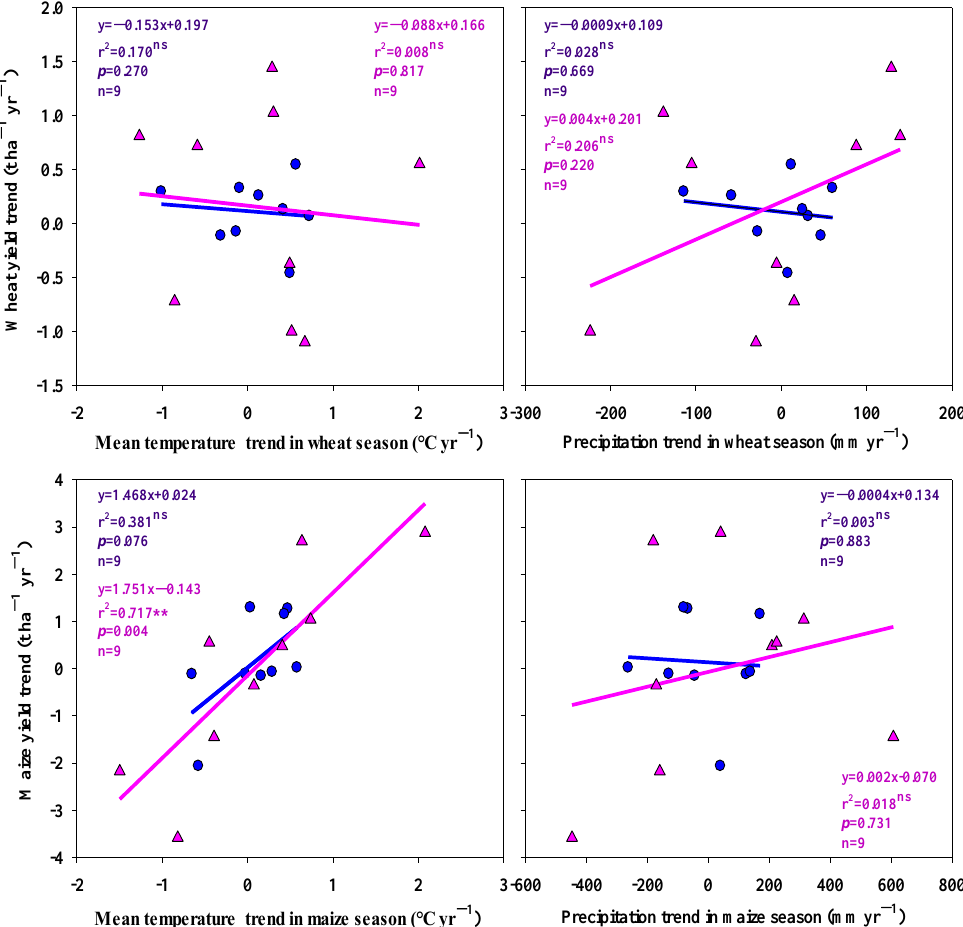
Figure 11. Correlation between wheat and maize yield and mean temperature trend and precipitation trend. The trend represents the difference of the following year minus the previous year. The blue circles and lines represent the data of the Tai’an experimental site, and the pink circles, lines, and formulas represent the data of the Longkou experimental site. r: correlation coefficient; p : significance level; n: sample size; **: significant at p < 0.01; ns : not significant.